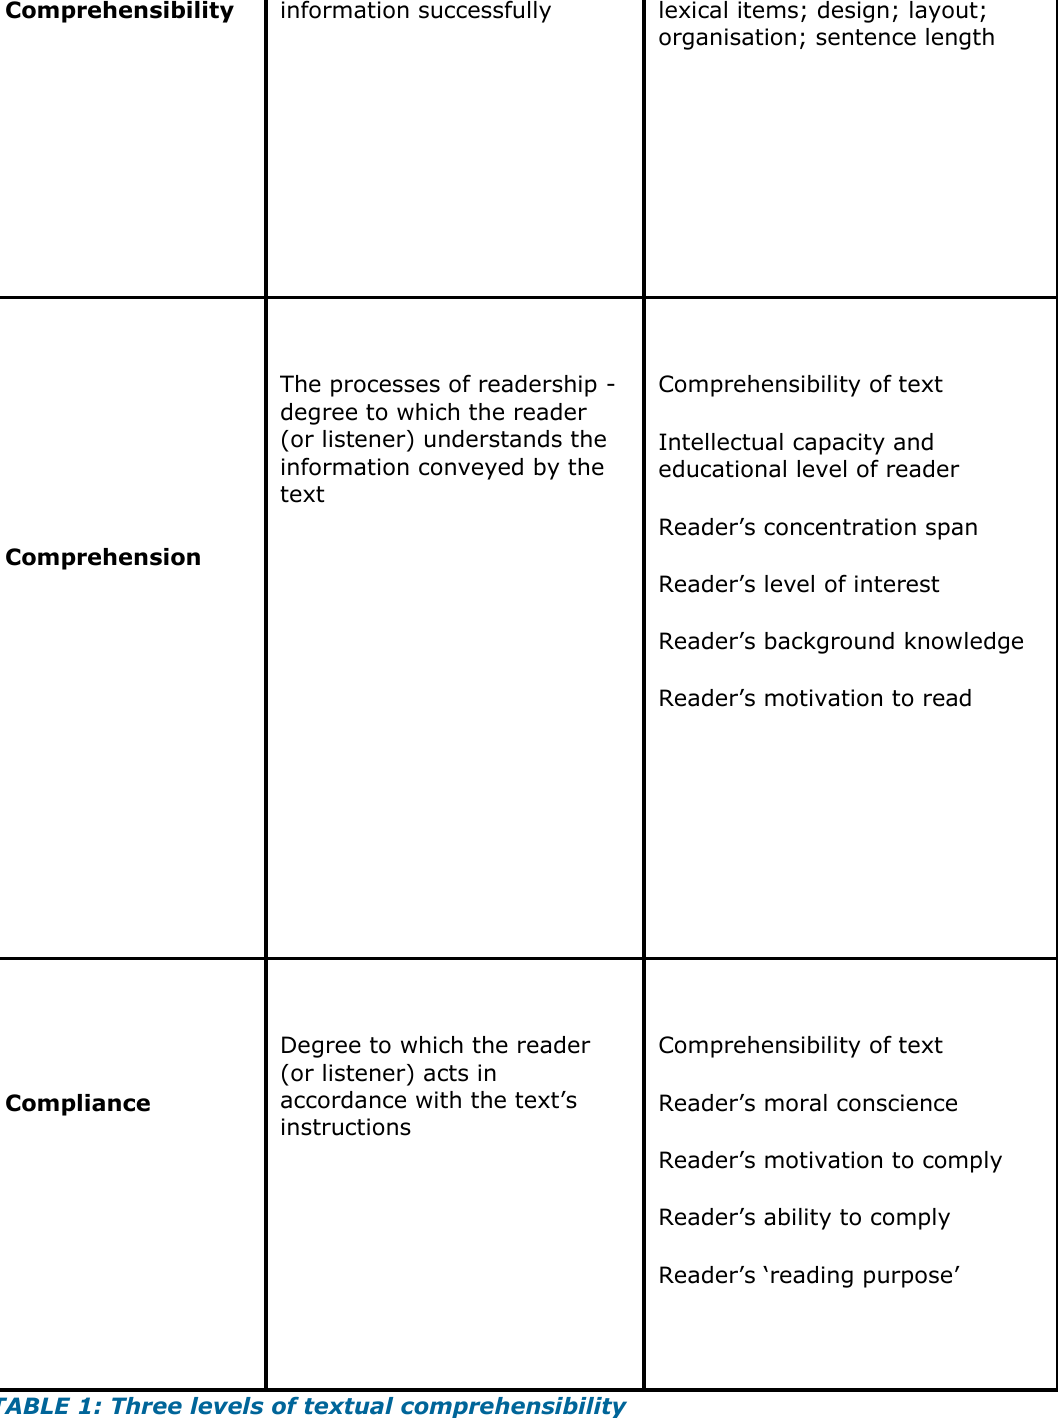
TABLE 1: Three levels of textual